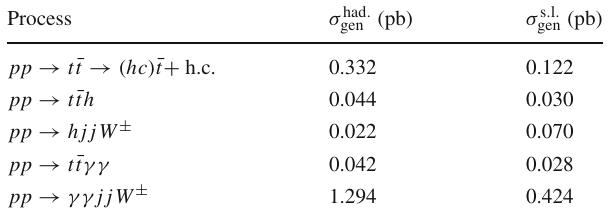
Table 2 The starting signal and background cross sections considered in the analyses of the top quark pair production search for the t → hc decay. For simplicity, we have rescaled the leading-order cross sections for all processes by a k -factor of 2. This approximation does not have a significant impact on our conclusions. The second and third columns show the generation-level cross sections for the hadronic and semi- leptonic cases, respectively, see main text for further details. The signal crosssectionsareshownfor λ h ct = 0 .